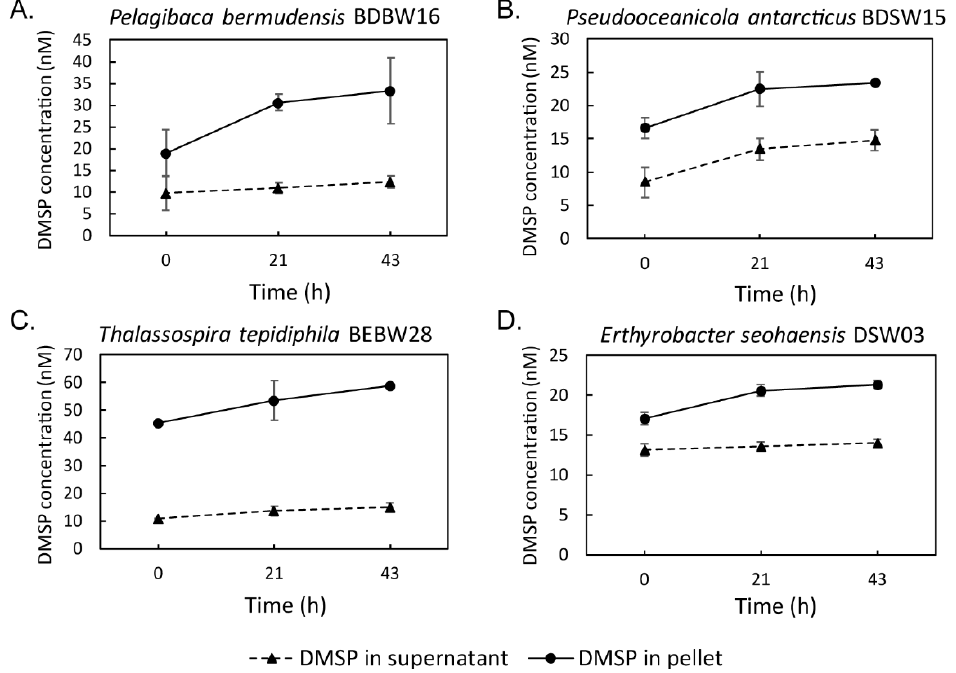
Figure 3. DMSP levels in axenic bacterial cells (pellet) and their cell-free supernatant when incubated in sterilized natural seawater. ( A ) The dsyB -containing isolate, Pelagibaca bermudensis BDBW16; ( B ) The dsyB -containing isolate Pseudooceanicola antarcticus BDSW15; ( C ) The mmtN -containing isolate Thalassospira tepidiphila BEBW28; ( D ) The isolate Erthyrobacter seohaensis DSW03 with unknown DMSP biosynthesis gene. Samples were taken at 0 h, after 21 h and 43 h, and DMSP determined by alkaline lysis purge and GC quantification. Error bars display standard deviation from the mean value (n = 3 biologically independent samples). All DMSP-producing isolates show increased intracellular (pellet) and extracellular (supernatant) DMSP levels after 21 and 43 h incubation.